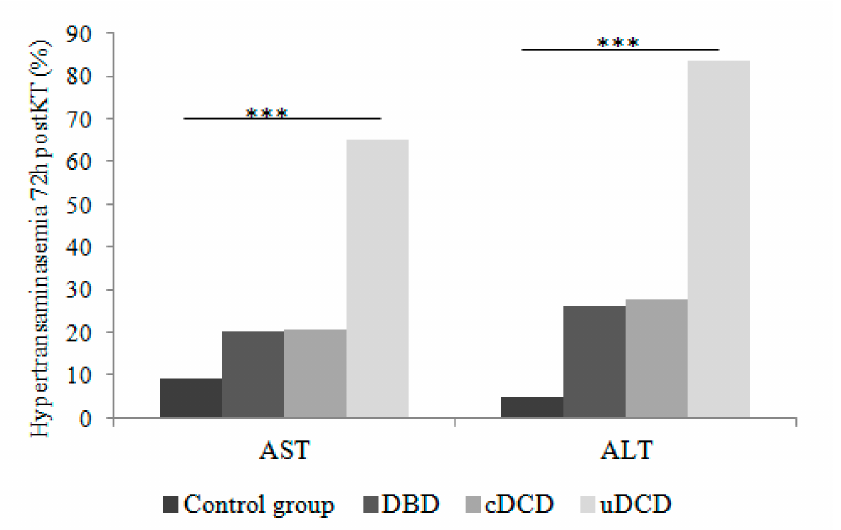
Figure 5. Percentage of KT recipients presenting hypertransaminasemia during the early posttrans- plant period according to the donor type. Comparisons with the control group. Comparisons between groups were made with Chi-Square test. Differences were found only between the control group and the uDCD group for both AST and ALT. *** p <